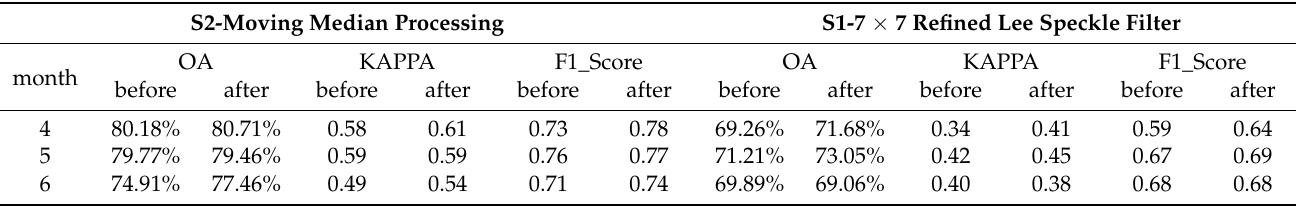
Figure 7. The number of good observations in the study area from April to September. Banded areas had a higher value due to the more S2 images are overlapped. The color in the graph represents the amount of data available on the pixel during the time interval. From “blue” to “red” indicates that the number of good observations increases gradually. Table 3. Comparison of maize classification accuracy before and after S2 and S1 image pre-processing. Preprocessing refers to moving median synthesis for S2 images and 7 × 7 Refined Lee spectral filtering for S1